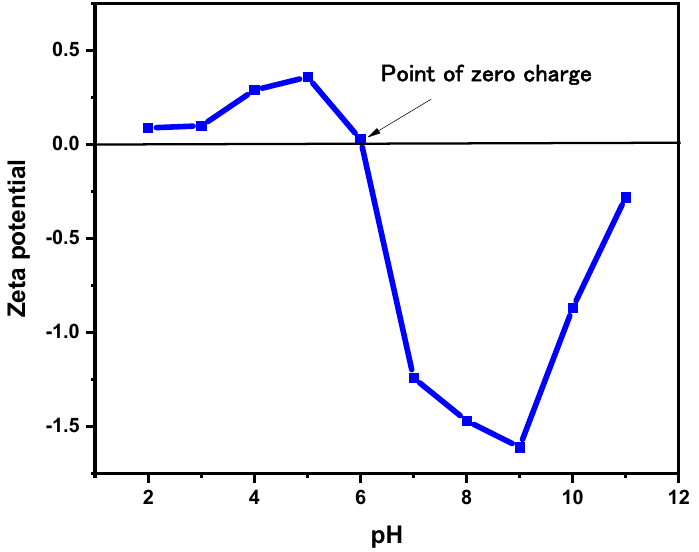
Figure 8. The zeta potential of Fe 2 O 3 /Mn 2 O 3 @SiO 2 (FMS) in different pH conditions. The degradation performance of RhB dye of a synthesized photocatalyst adsorbent, FMS, was evaluated and compared under different reaction conditions. Figure 7d shows the degradation of RhB using four methods: UV (photolysis), adsorption, Fenton, and photo-Fenton. FMS (100 mg) was added to 100 mL of RhB solution at a concentration of 10 ppm over a 2 h reaction time to evaluate its performance under different conditions. Figure 7d clearly shows adsorption indicating the impact of FMS on the removal of RhB, resulting in 84.2% removal of the RhB aqueous solution. Interestingly, photolysis